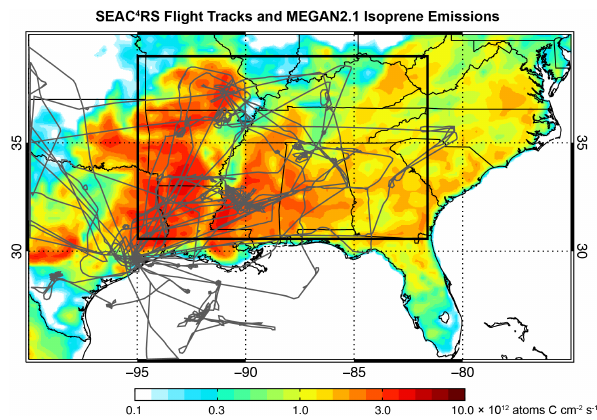
Figure 2. Flight tracks of the DC-8 aircraft during SEAC 4 RS, su- perimposed on mean MEGAN2.1 isoprene emissions for August– September 2013. The thick black line delineates the southeast US domain as defined in this paper (95–81.5 ◦ W, 30.5–39 ◦